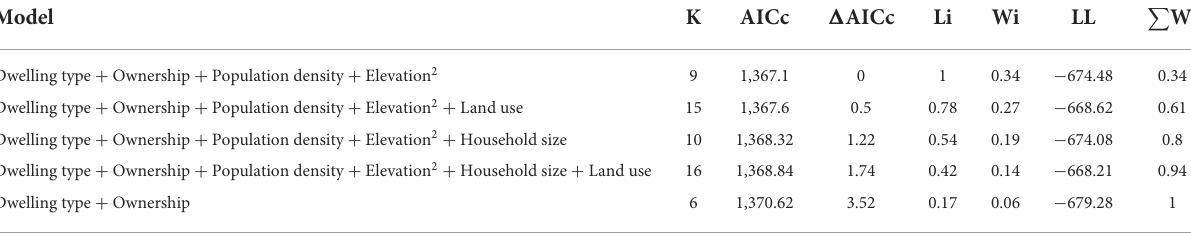
TABLE 2 A reduced candidate model list ranked using Akaike Information Criterion (AIC) to explain the probability of dog ownership of residents of Costa Rica. Model